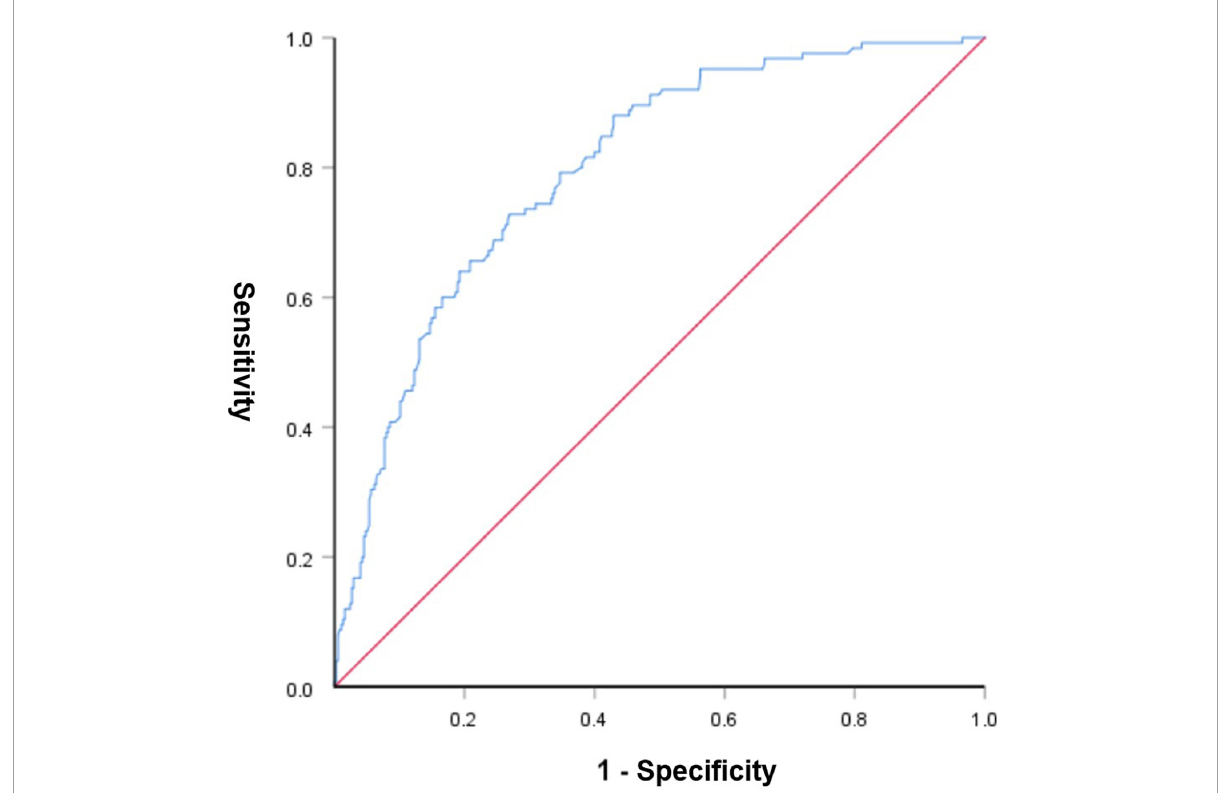
FIGURE4 Receiver operating characteristic curve of the predictive nomogram. The area under the ROC was 0.801, demonstrating good discriminative ability of the model.